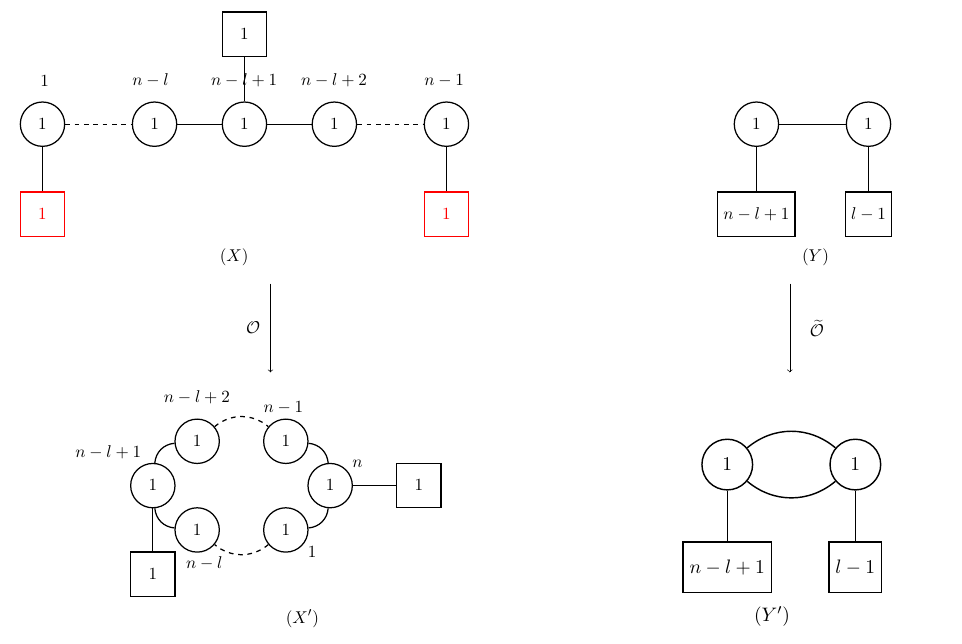
Figure 16 . The quiver ( X 0 ) and its mirror dual ( Y 0 ) are generated by an elementary S-type operation O = G ◦ F ◦ I of the identification-flavoring-gauging type on the linear quiver X and the dual operation e O on the linear quiver Y . The flavor nodes on which O acts are shown in red on the first line. The dual operation simply involves adding a single bifundamental hyper in the quiver Y .